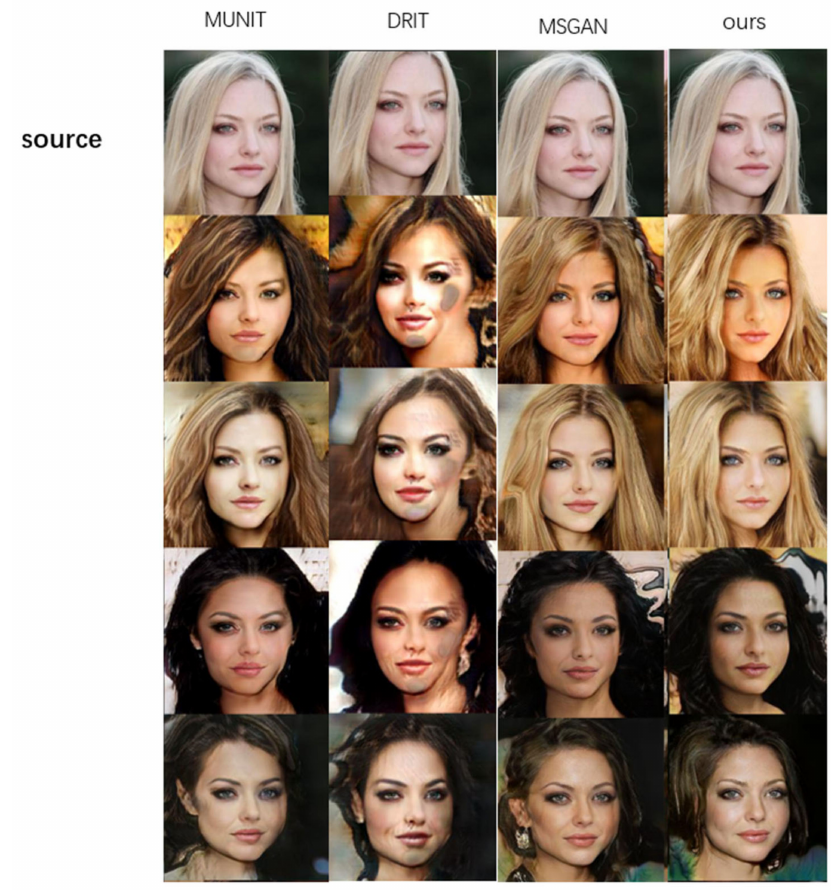
Figure 7. Using random noise to guide generation of images in